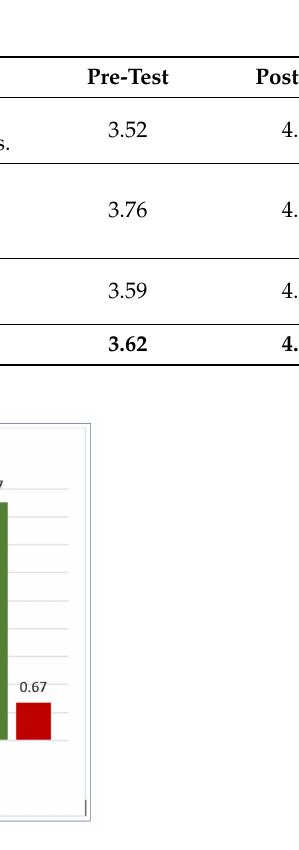
Figure 8. Students’ problem organization in the previous test and the